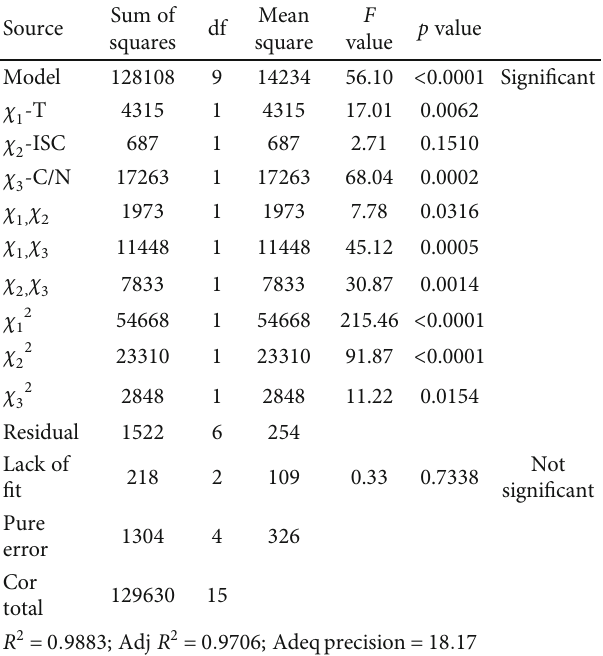
Table 4: ANOVA for the quadratic model of SS-AD biogas